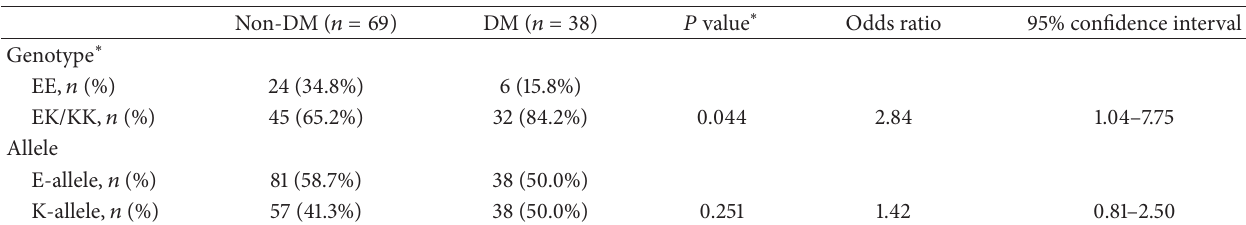
Table 2: Genotypic distribution of E23K polymorphism of the Kir6.2 between normal control and type 2 diabetes subjects. Non-DM ( 𝑛 = 69